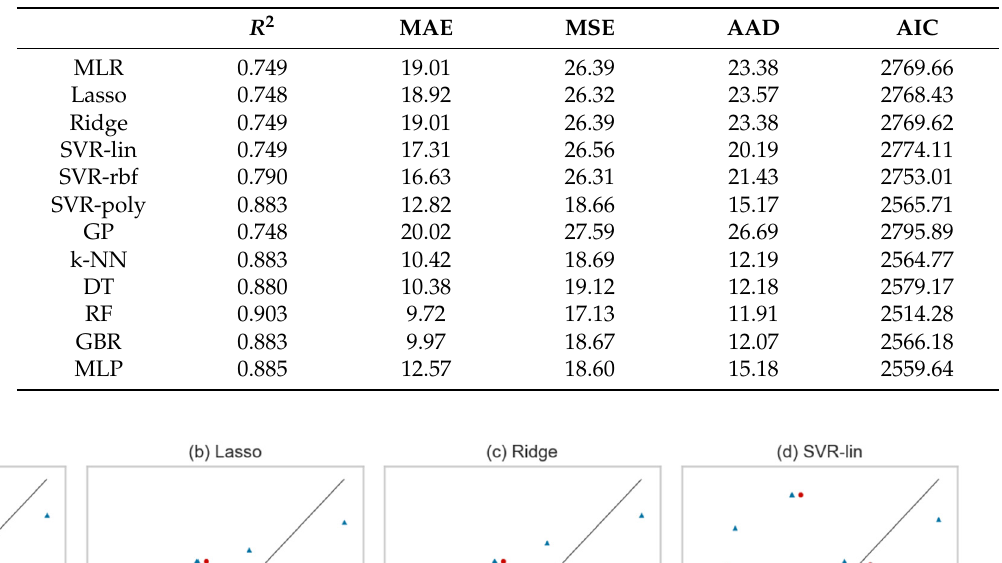
Table 7. Calculated metrics for all ML algorithms applied to the dataset for the reduced case with six PCA inputs.